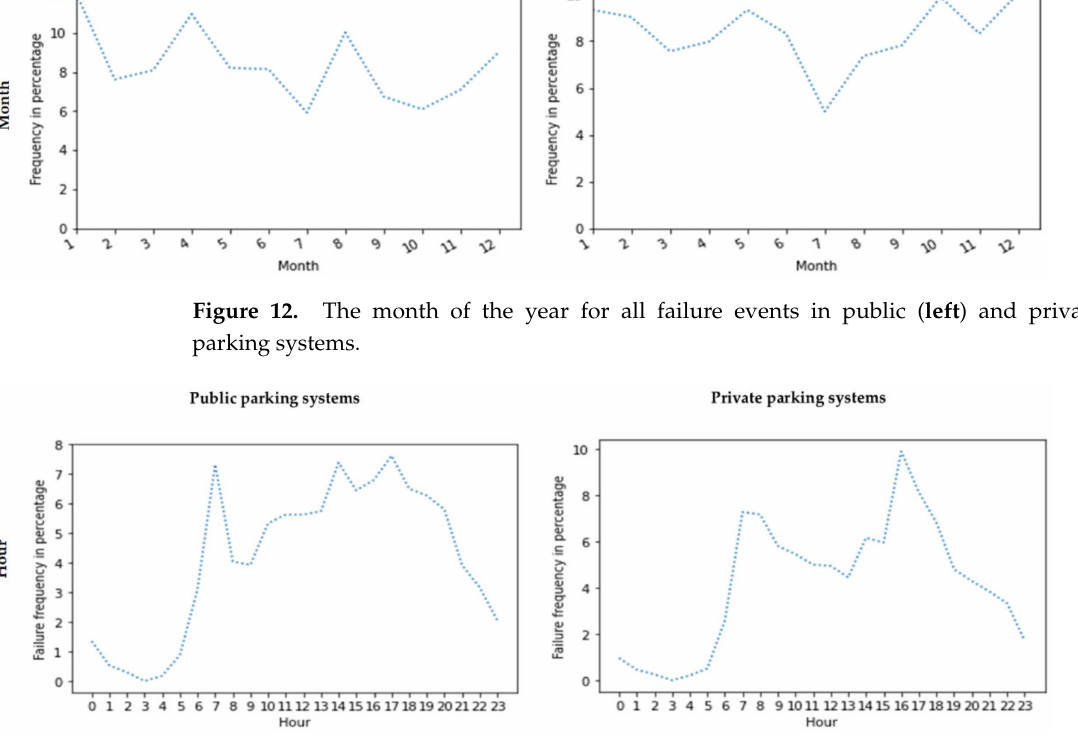
Figure 13. Time of day (hour) for all failure events in public ( left ) and private ( right ) parking systems. Gate as a Use